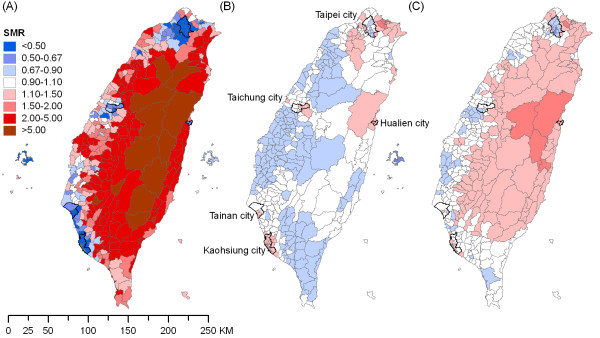
Mapsa for (A) pesticide, (B) non-pesticide and (C) overall suicideb across Taiwan's 358 districts, 2002-2009. aSmoothed standardized mortality ratios (SMRs) were mapped here. bIncluding certified suicide, undetermined death, and accident from pesticide poisoning and suffocation.